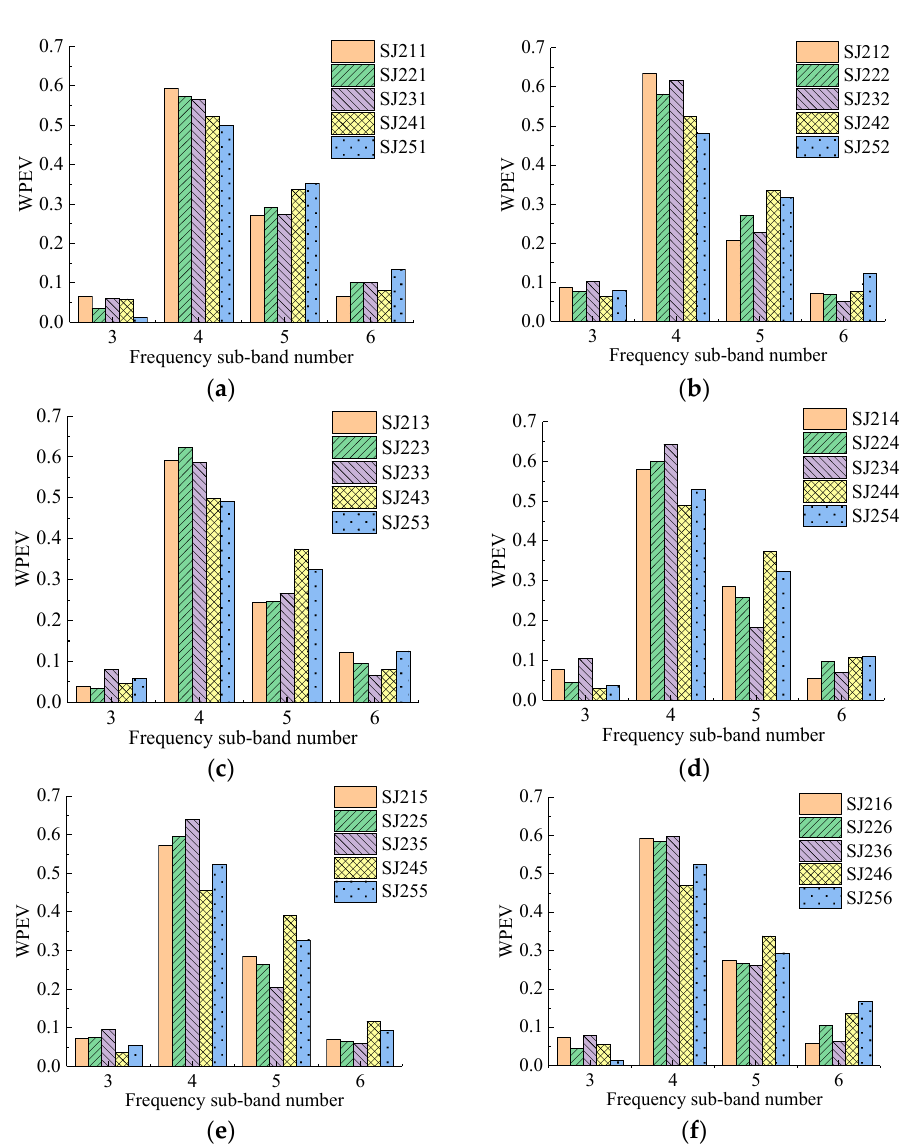
Figure 6. The wavelet packet energy vectors (WPEVs) of different detecting points of SJ1 group. ( a ) Detecting point 1, ( b ) Detecting point 2, ( c ) Detecting point 3, ( d ) Detecting point 4, ( e ) Detecting point 5.